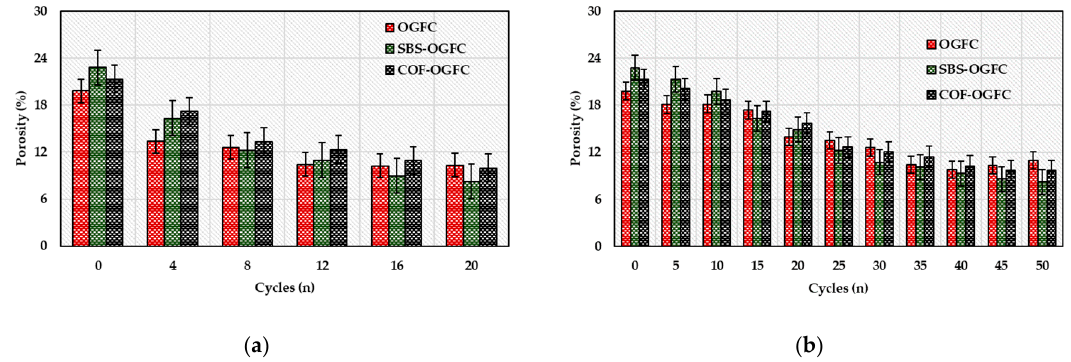
Figure 9. Porosity of the three permeable asphalt mixtures with different cycles. ( a ) Spring clogging procedure; ( b ) Summer clogging procedure.